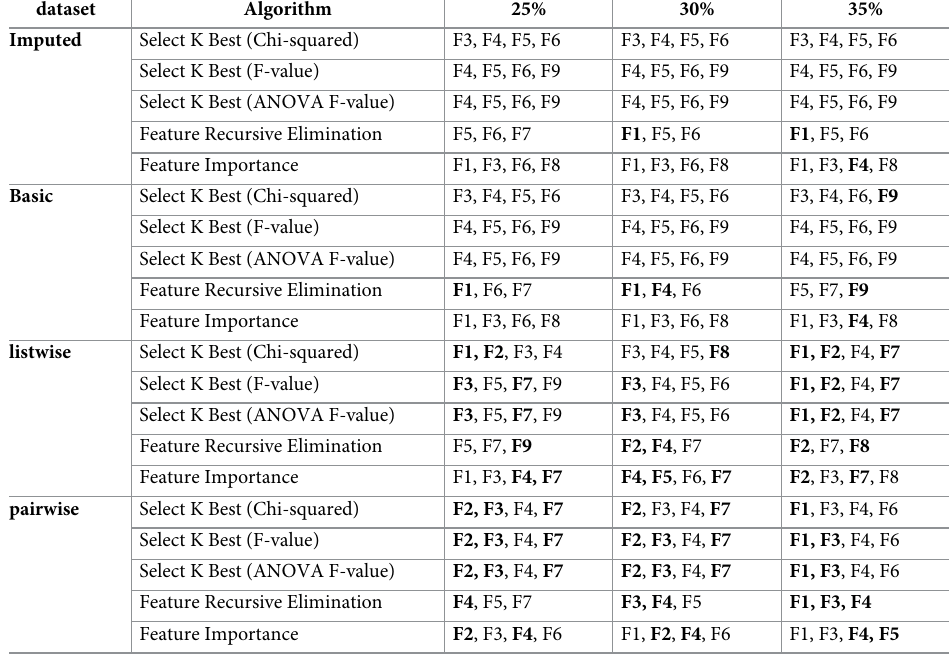
Table 22. Results of feature selection of simulated